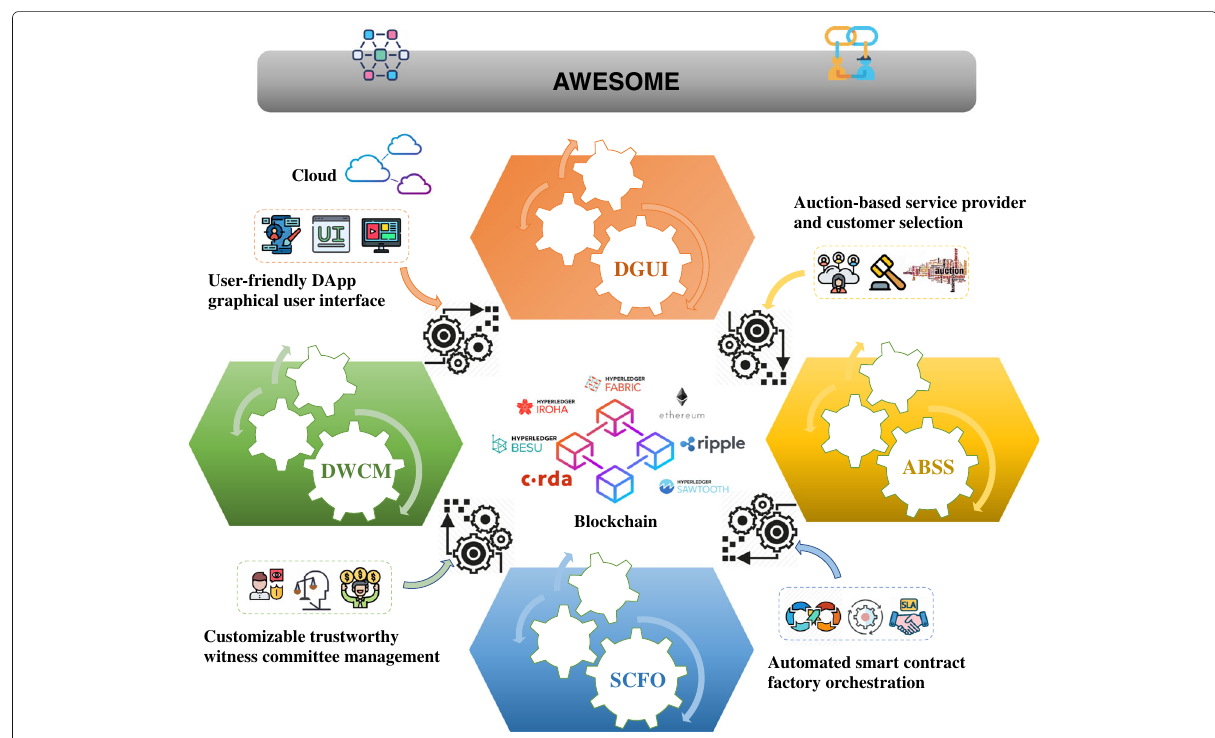
Fig. 2 The overall architecture of the AWESOME framework